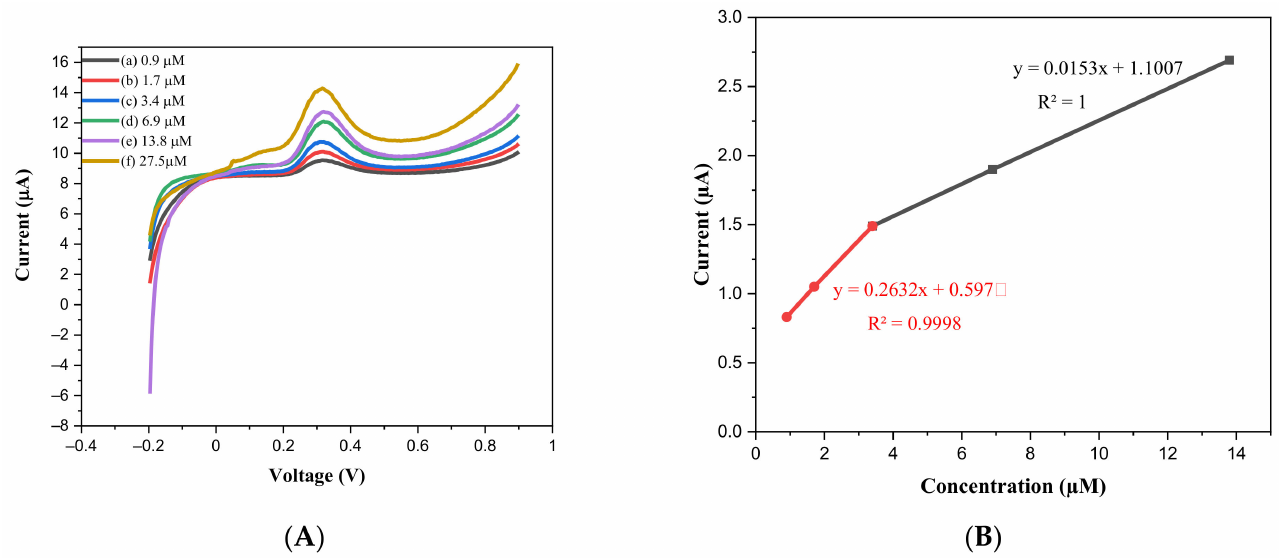
Figure 6. ( A ) DPV I-V curve of 1%Pd/BiVO 4 /GCE with various concentrations of epinephrine (a) 0.9 µ M (b) 1.7 µ M (c) 3.4 µ M (d) 6.9 µ M (e) 13.8 µ M (f) 27.5 µ M; ( B ) The plot of DPV current against various epinephrine concentrations at 1%Pd/BiVO 4 /GCE.